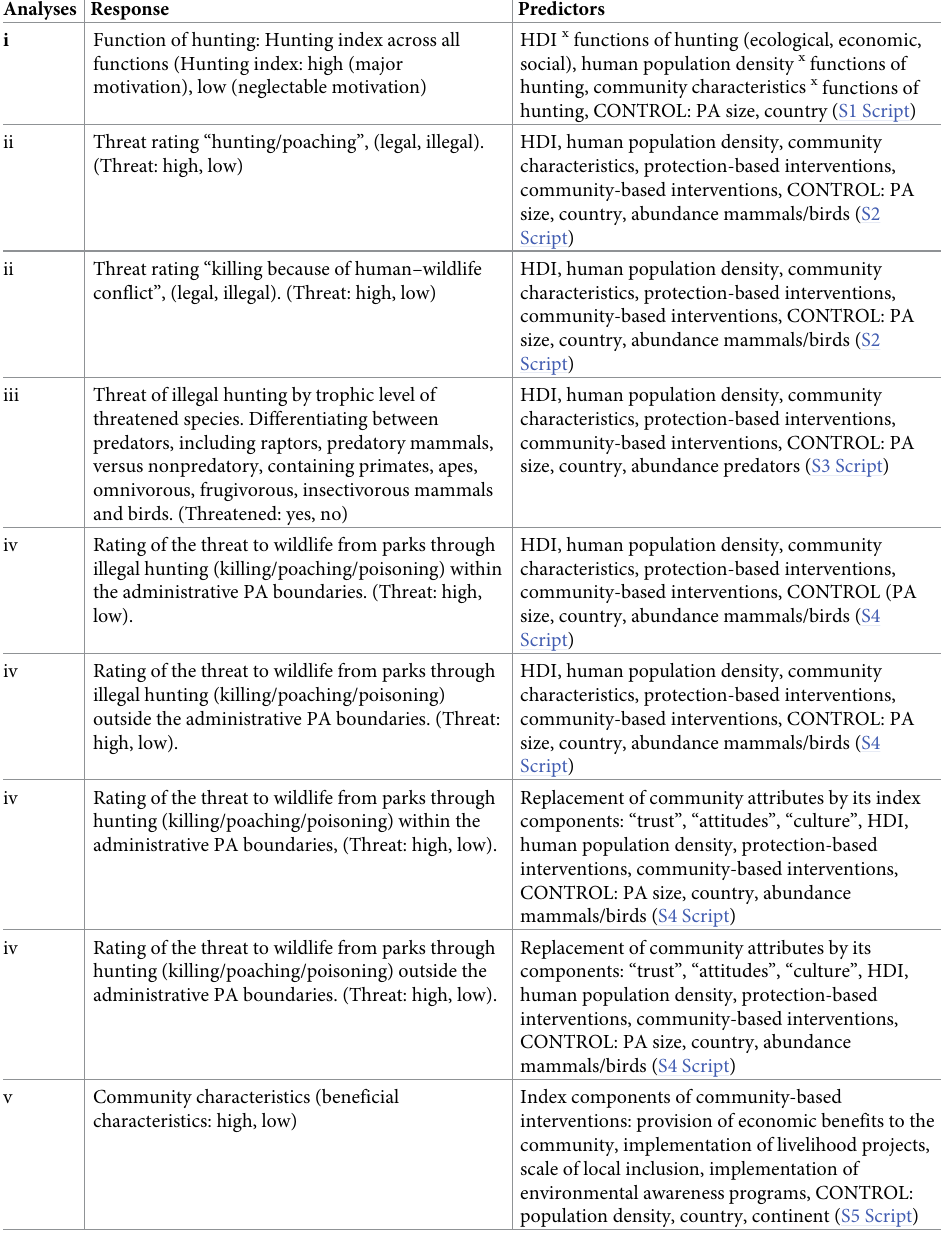
Table 1. Overview of the 7 response variables and predictors in each of the 9